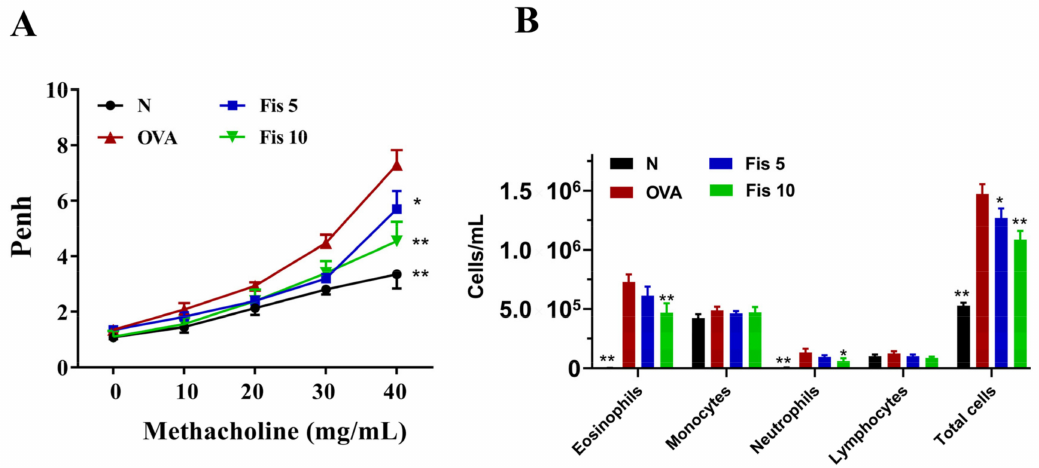
Figure 8. Effect of fisetin (Fis) on AHR and cell counts in BALF. ( A ) Mice inhaled increasing doses of methacholine before assessing AHR, which is shown as Penh values. ( B ) Inflammatory cells in the BALF were counted. The data presented as mean ± SEM of three independent experiments ( n = 8 per group). * p < 0.05, ** p < 0.01, compared to the OVA control group. N: Normal group; OVA: mice sensitized with OVA. OVA-sensitized mice treated with 5 mg/kg or 10 mg/kg fisetin were named as Fis 5 and Fis 10,